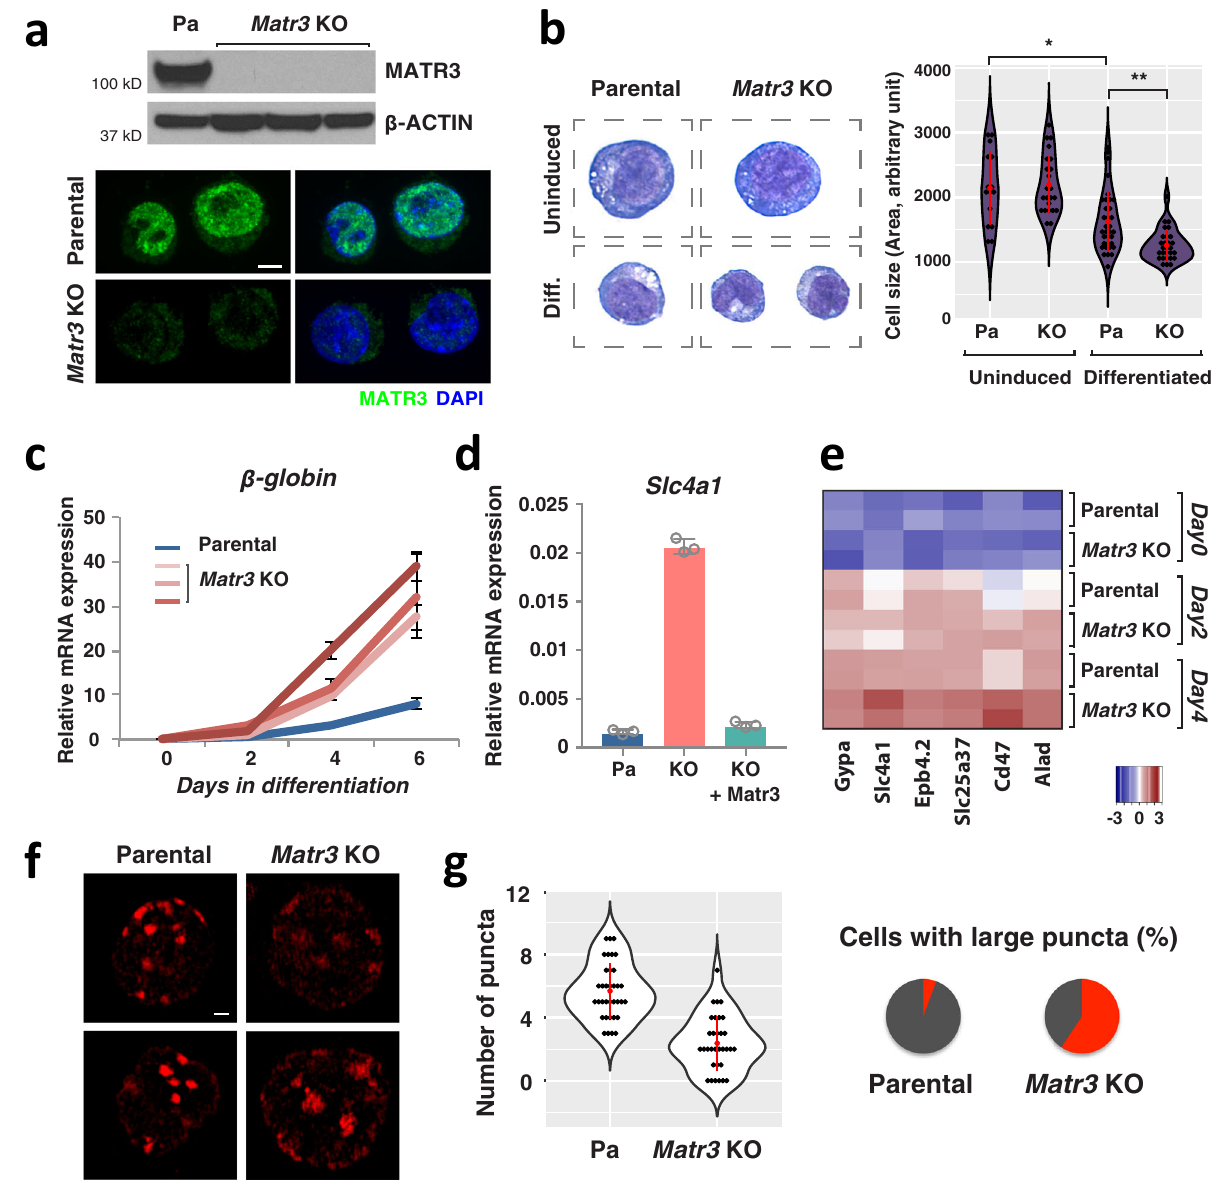
Fig. 1 Altered nuclear structure and differentiation following Matr3 loss. a MATR3 expression was assessed in parental and Matr3 KO MEL cells by Western blot and immunohistochemistry. β -actin was used as a Western blot control. Scale bar, 5 μ m. b May-Grunwald Giemsa staining was performed on uninduced and 5-day differentiated cells. During MEL cell differentiation, cell size is normally reduced ( p = 0.002, by t test); the effect is more pronounced in Matr3 KO cells ( p = 0.0004, by two-sided t test). The number of examined cells was n = 15, n = 23, n = 34, and n = 28, respectively. c β -globin mRNA expression was greater in Matr3 KO than normal MEL cells, indicative of enhanced cell differentiation ( n = 3). Three independent Matr3 KO clones by CRISPR/Cas9 were examined. d mRNA encoding Slc4a1 , an erythroid-speci fi c gene, was also increased in Matr3 KO cells; expression of full-length Matr3 cDNA (Fig. S1c) lowered Slc4a1 expression to wild-type levels ( n = 3). e Relative RNA levels based on z-score analysis demonstrated that expression of late erythroid genes was signi fi cantly higher in Matr3 KO than wild-type cells upon differentiation. P -values obtained from the two-sided t test between two groups at each day were 1.94e-01, 1.37e-02, and 3.65e-07, respectively. f Heterochromatin was visualized by immunohistochemistry using anti-HP1 α antibody and super-resolution microscopy. Scale bar, 1 μ m. g The number of distinct puncta per cell ( p < 5.9e-11; n = 35, n = 32, respectively) and percentage of cells with at least one large puncta were quanti fi ed (5.7% and 59.4%, respectively). A large puncta was de fi ned as having the longest diameter that is more than twice the average. Data were the result of 2 – 3 independent experiments and error bars represent mean ± 1 s.d. Source data are provided as a Source Data fi